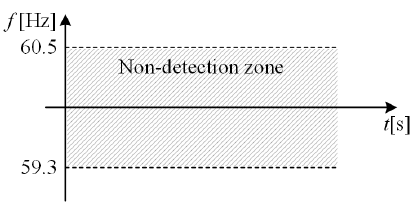
Figure 6. Non-detection zone frequency range of the